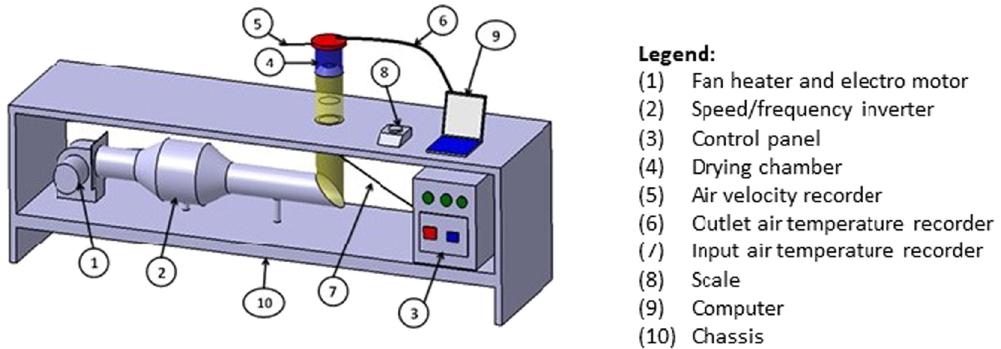
Figure 1: Schematic representation of the laboratory - scale fl uid - bed